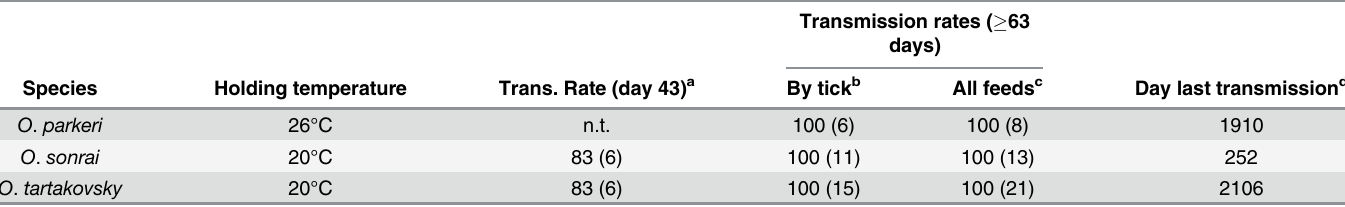
Table 2. Transmission of virus by Ornithodoros ticks after intracoelomic inoculation of 10 4 SMLD 50 of Karshi virus.